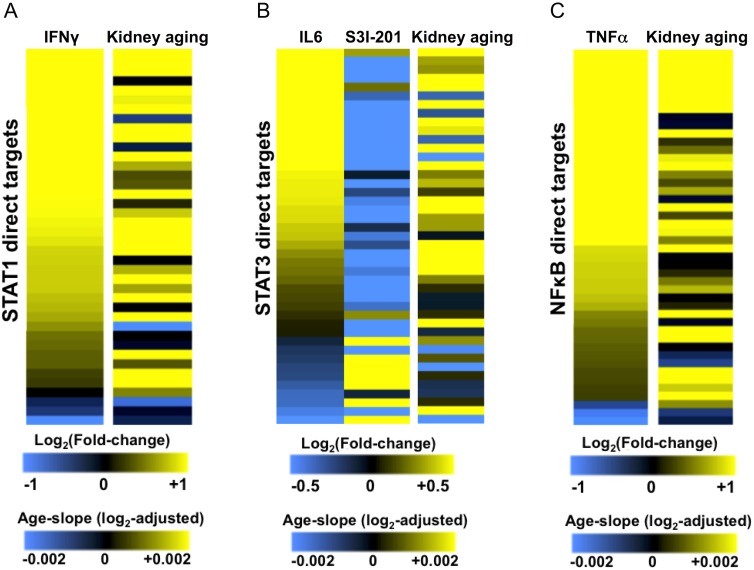
Activation of STAT1, STAT3 or NFκB by inflammatory cytokines recapitulates kidney aging-related gene expression patterns in human renal epithelial cells.A. The left column of the heat map shows the log2 fold-changes of 40 direct targets of STAT1 following IFNγ stimulation of HK-2 cells from microarray expression profiling experiments. The right column of the heat map shows the corresponding log2-adjusted beta coefficient (age-slope) for these STAT1 direct targets during kidney aging. B. The left column of heat map shows the log2 fold-changes of 43 direct targets of STAT3 following IL-6 stimulation of HK-2 cells from microarray expression profiling experiments. The middle column shows changes in expression following treatment with the STAT3 inhibitor S3I-201. The right column shows the corresponding log2-adjusted beta coefficient (age-slope) during kidney aging. Aging gene expression data are from [1]. C. The left column of the heat map shows the log2 fold-changes of 43 direct targets of NFκB following TNFα stimulation of HK-2 cells from microarray expression profiling experiments. The right column of the heat map shows the corresponding log2-adjusted beta coefficient (age-slope) for these NFκB direct targets during kidney aging. Yellow indicates increased gene expression (positive fold-change or age-slope) and blue indicates decreased gene expression (negative-fold change or age-slope).